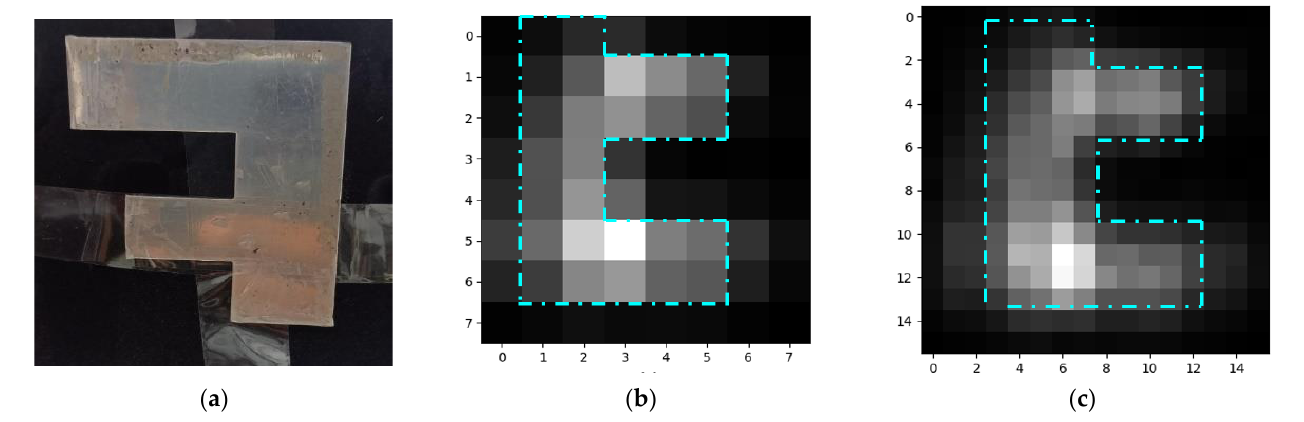
Figure 7. ( a ) ‘F’-shaped metallic object, ( b ) 8 × 8 Grayscale image, and ( c ) the oversampled 16 × 16 Grayscale image.